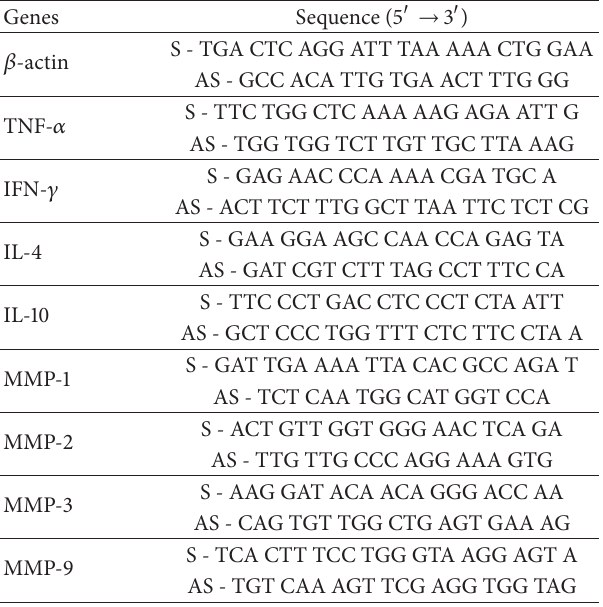
Table 2: Human primers sequences for real-time PCR used in this